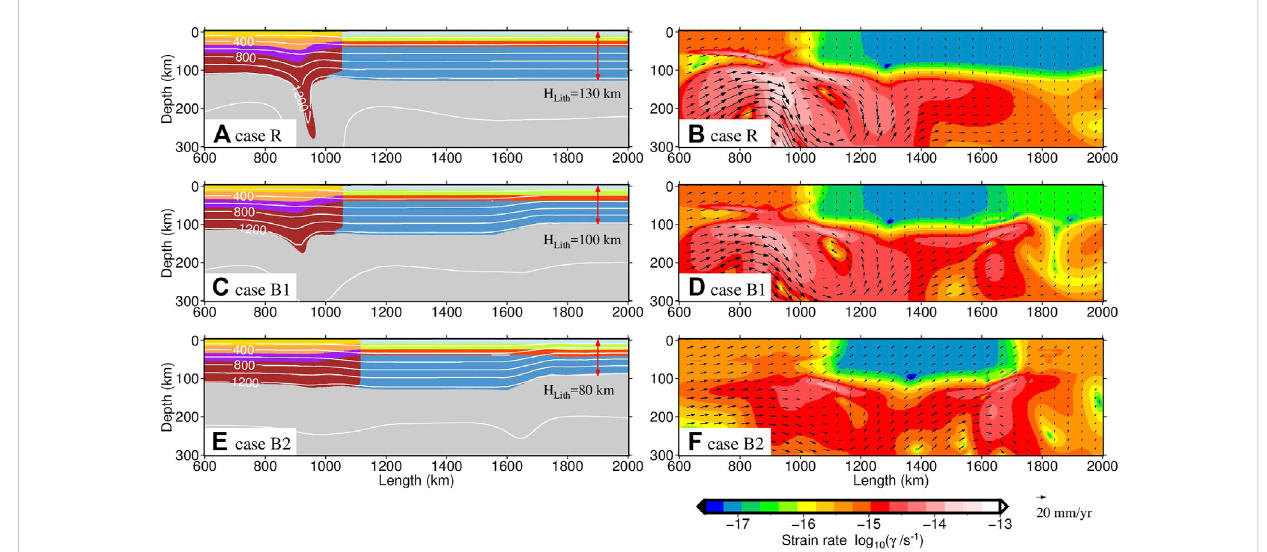
FIGURE 6 Comparisons of lithospheric deformation (A,C and E) and strain rate localization (B,D and F) for different cases (cases R, B1, and B2) after 10 Myr convergent. Different colorsin (A,C and E) indicates different materials, whichare consistent with that inFigure2A. White lines in (A,C and E) indicate the isotherm. Black arrows in (B,D and F) show velocity vectors. Double-headed red arrows in (A,C and E) indicate that the initial lithospheric thicknesses of the right part of the craton. H Lith presents the initial thickness of the lithosphere.